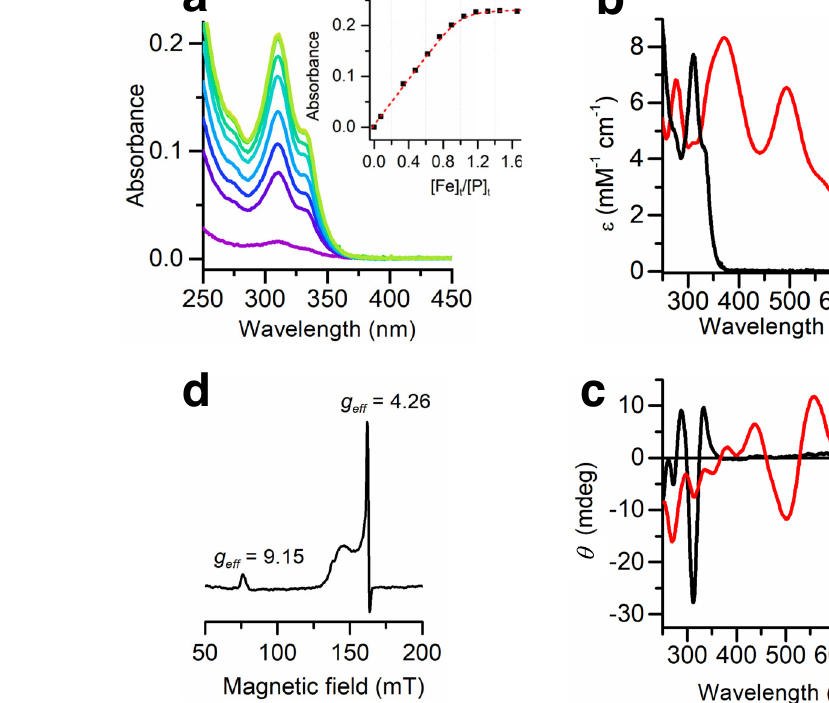
Vis and CD spectra of the reduced (black line) and oxidized (red line) FeMETPsc1 (40 μ M) species. d X-band CW-EPR spectrum of Fe 3+ METPsc1 (0.5mM) in 20mM phosphate buffer (pH 7) and 5mM TCEP at 4.5K. Source data are provided in a Zenodo repository under accession code